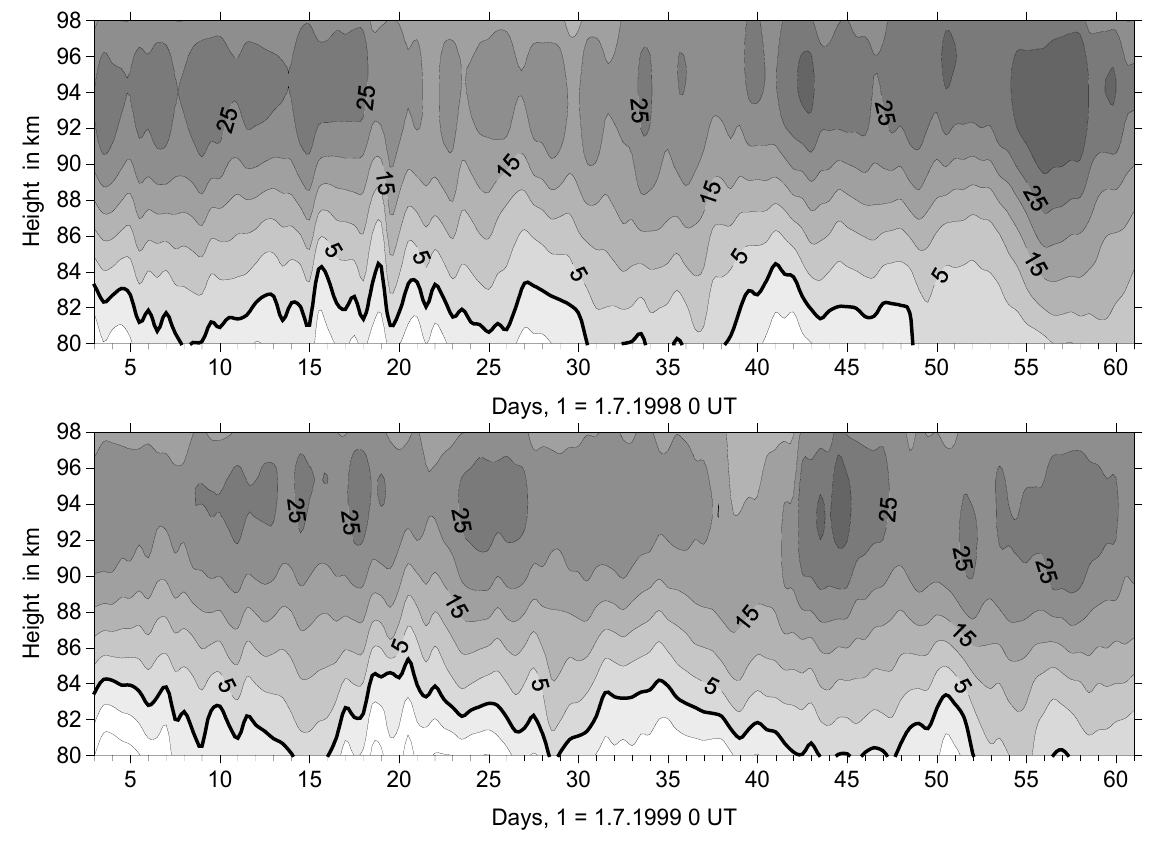
Fig. 3. Height-time cross sections of background zonal winds during July and August 1998, 1999. Data are calculated using a 96-h window Figure 3: Height-time cross-sections of background zonal winds during July and August each. 1998, 1999. Data are calculated using a 96 h window each.